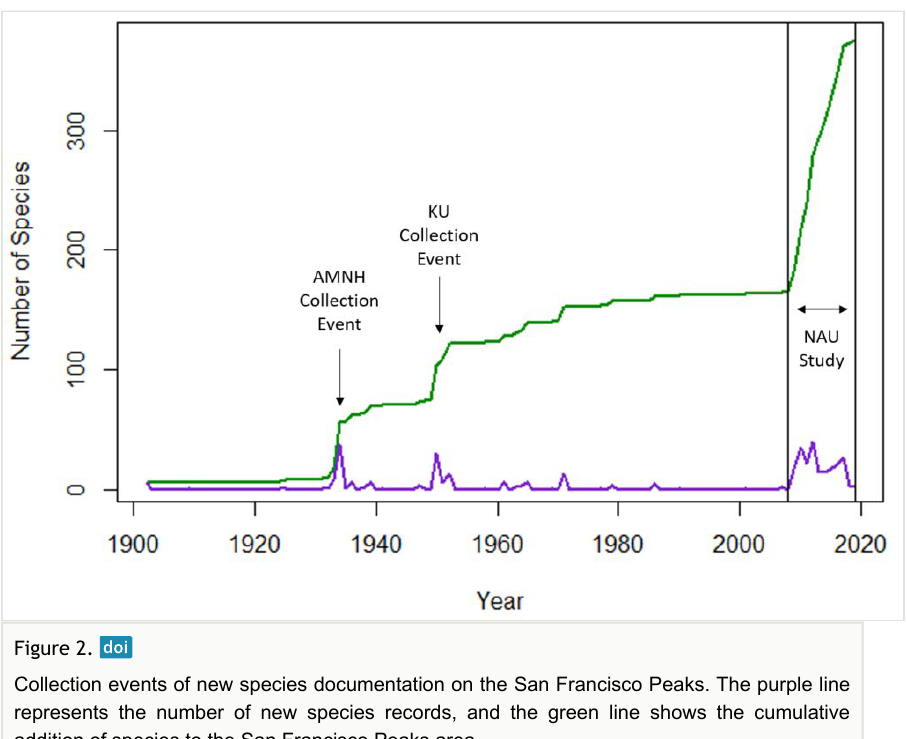
Collection events of new species documentation on the San Francisco Peaks. The purple line represents the number of new species records, and the green line shows the cumulative addition of species to the San Francisco Peaks Our study that began in 2009 was a collaborative inventory project with Northern Arizona University and United States Fish and Wildlife Service and was started with the intention of documenting all bee species inhabiting the Peaks region. Over a 10-year period, we documented an additional 204 bee species inhabiting the Peaks, leading to a total of 359 bee species recorded on this checklist (7,952 specimens Table 2). The ponderosa pine life zone is the most diverse, with a total of 177 species inhabiting that vegetation zone (Fig. 3). However, collection effort in the desert shrub and desert grassland life zones was disproportionately lower than that of the four higher life zones. Desert shrub and desert grassland were only sampled in 2009-2012. Further, only pollinator cups were used at desert shrub and desert grassland, whereas bug vacuums became the primary method of sampling at the pinyon-juniper, ponderosa pine, mixed conifer, and spruce-fir life zones from 2016-2019. These two components could potentially lead to a higher abundance of specimens collected at those four higher life zones.